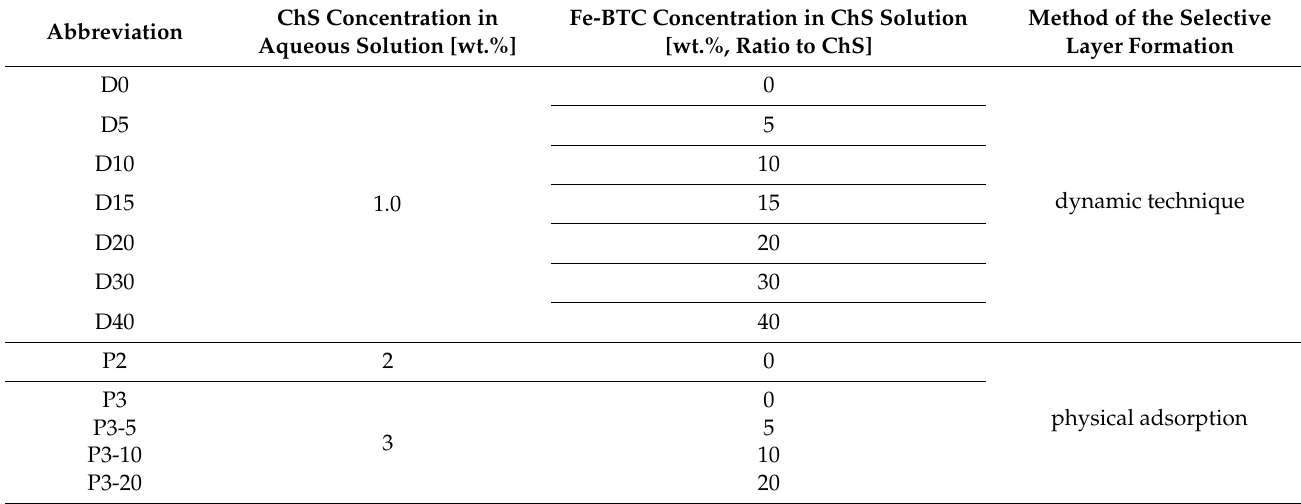
Table 1. TFC and TFN membrane abbreviations and preparation